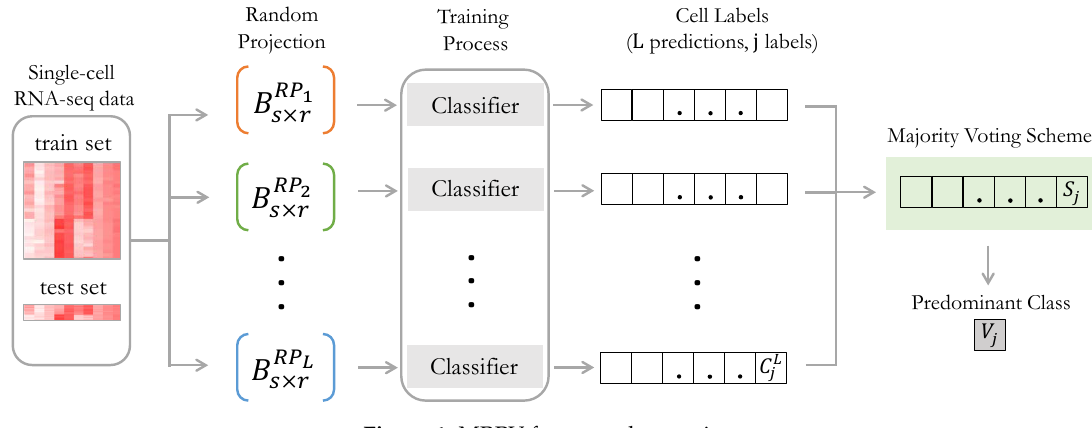
Figure 1. MRPV framework